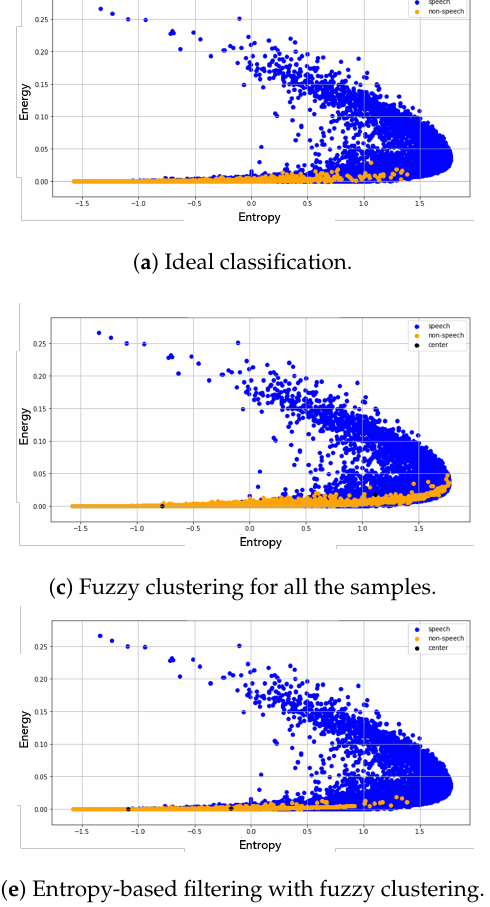
Figure 19. Analysis of the accuracy improvement of entropy-based filtering with fuzzy